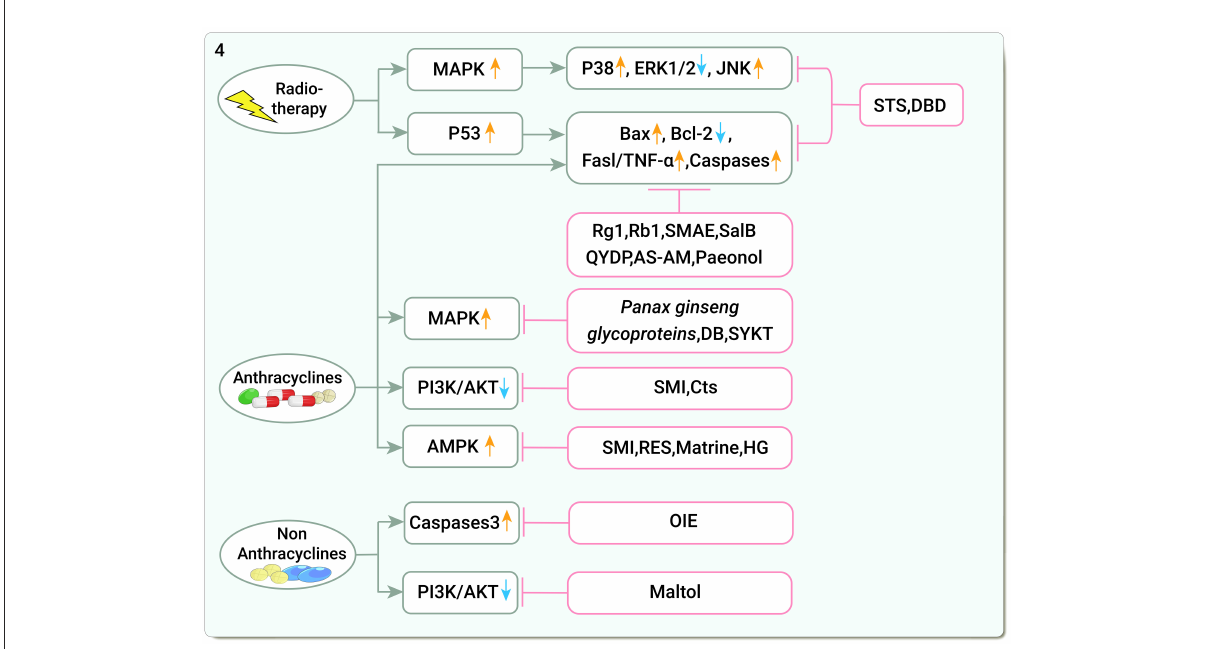
FIGURE4 Traditional Chinese medicine alleviates cardiotoxicity associated with chemoradiotherapy by reducing apoptosis (MAPK, Mitogen-activated protein kinase; ERK1/2, Extracellular signal-regulated kinases1/2; JNKs, C-Jun-terminal kinases; Bax, Bcl-2 associated X; Bcl-2, B-cell lymphoma-2; Fasl/TNF- α , FasLigand/tumor necrosis factor- α ; Caspases, Cysteine aspartate proteases; PI3K/AKT, Phosphatidylinositol 3-kinase/serine-threonine protein kinase; AMPK, Adenosine monophosphate-activated protein kinase; STS, Tanshinone IIa sodium sulfonate; DBD, Danggui Buxue decoction; Rg1, ginsenoside Rg1; Rb1, ginsenoside Rb1; SMAE, Salvia miltiorrhiza aqueous extract; SalB, Salvianolic acid B; QYDP, Qishen Yiqi Dropping Pills; AS-AM, Angelica Sinensis and Astragalus membranaceus Bunge Ultrafiltration Extract; DB, Diethyl